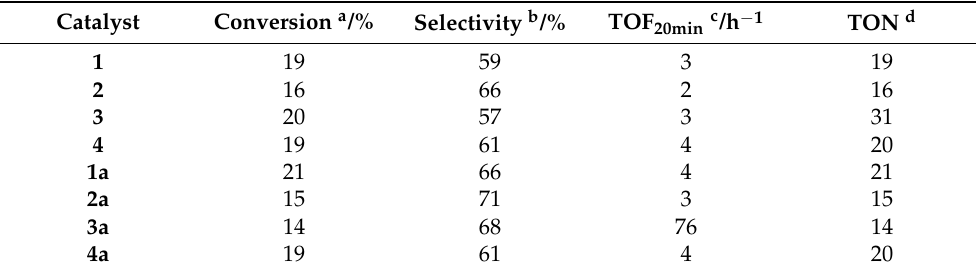
Table 4. Results of the cyclohexanol oxidation catalysed with molybdenum(VI) complex in the presence of H 2 O 2 after 5 h ( n (Mo): n (substrate): n (oxidant) = 1:100:300, T = 353 K). Catalyst